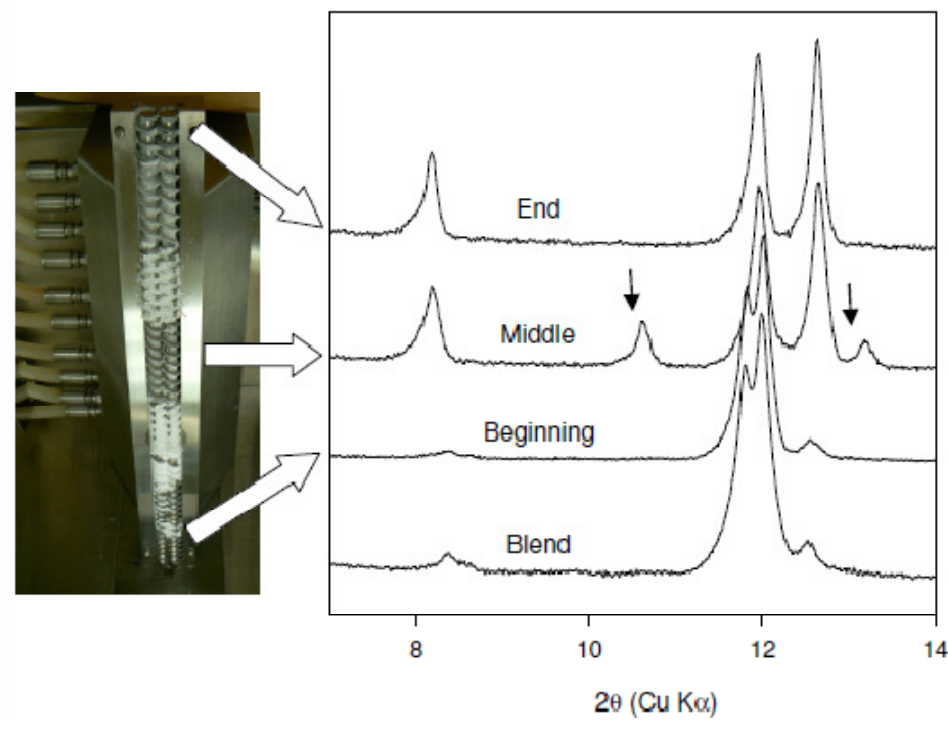
Figure 4. XRPD patterns showing the progressive conversion to the cocrystal for samples removed from the beginning, middle and end of the extruder barrel. New reflections at 10.6 and 13.2° 2 θ are marked with an